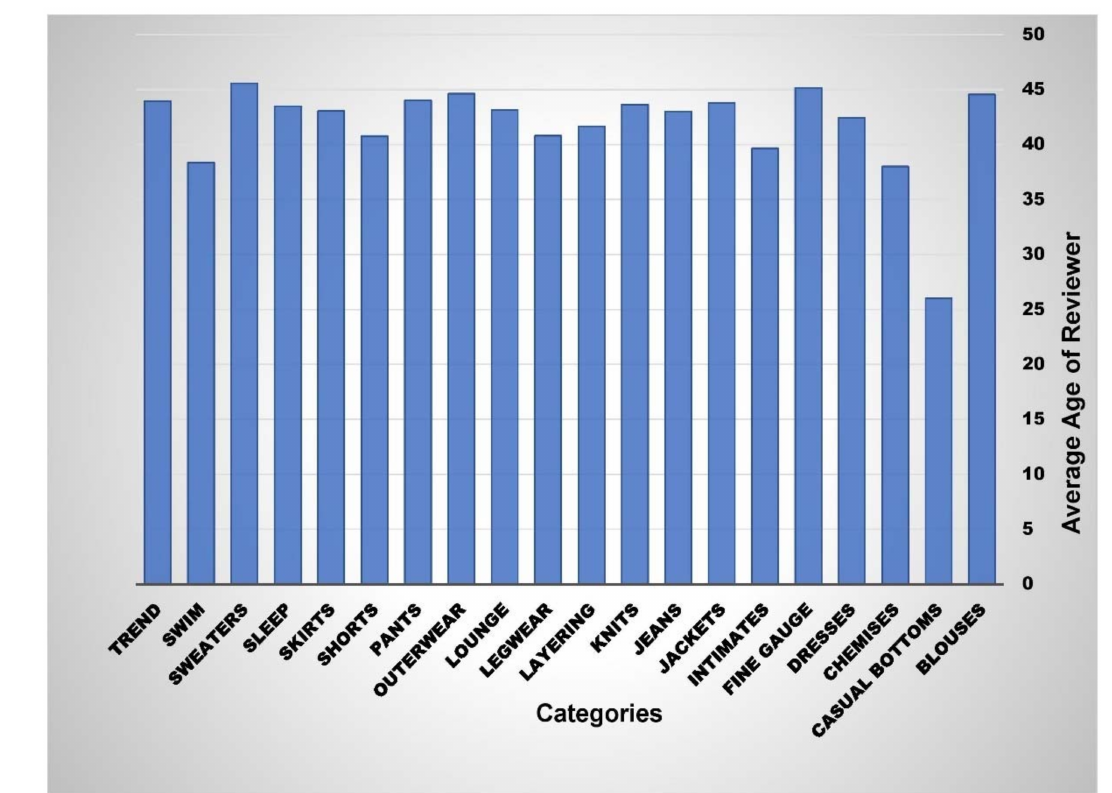
Figure 7. Product categories comparison based on